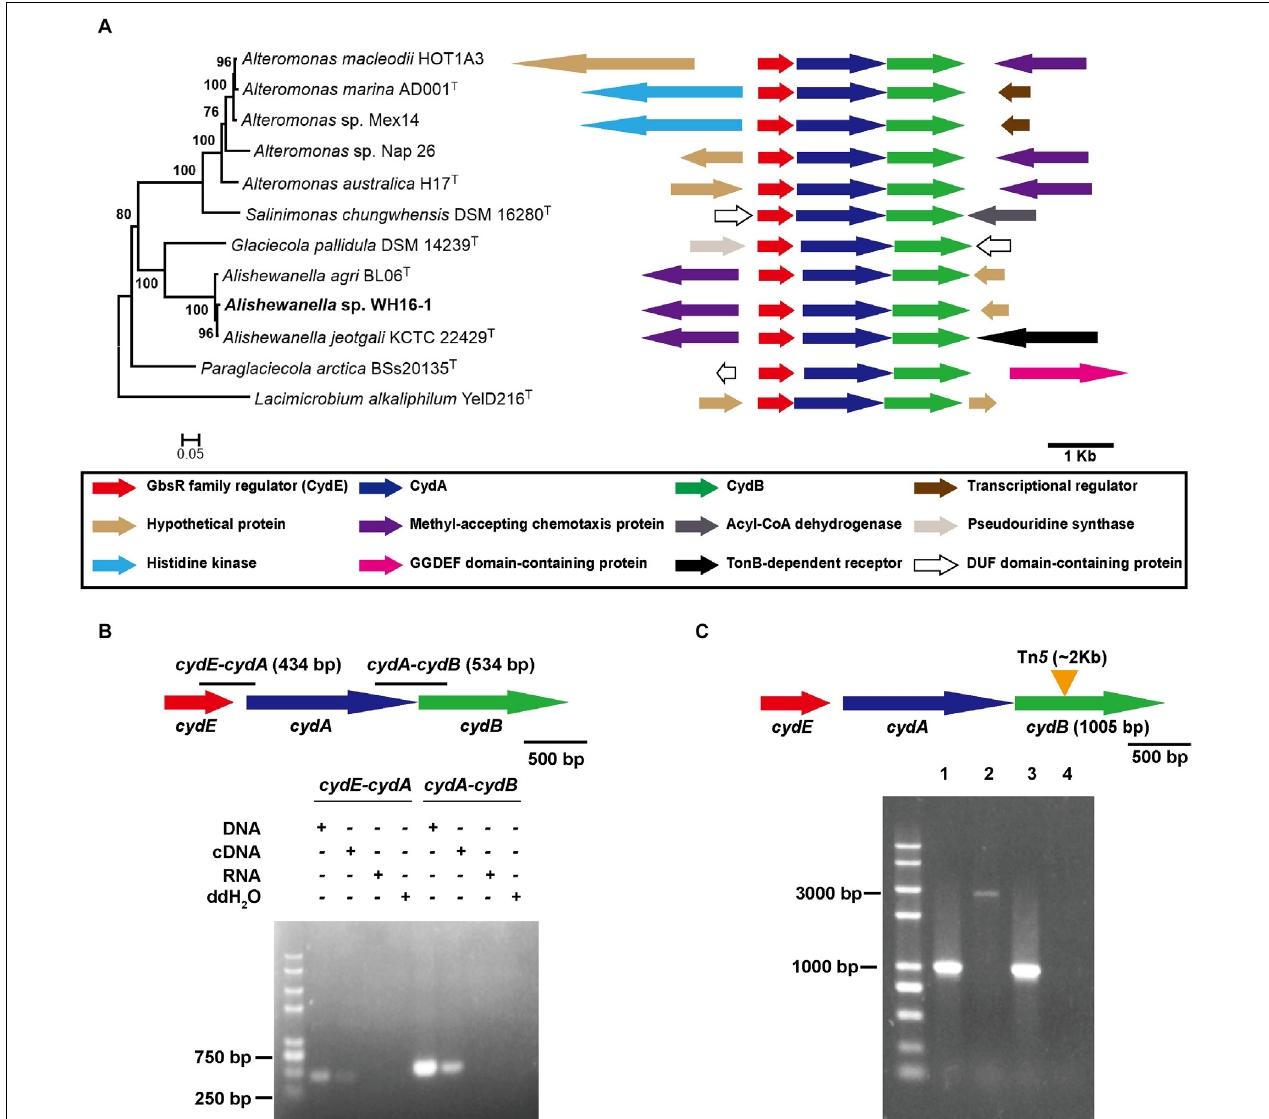
FIGURE 1 | Analysis of cytbd gene operon, cydB mutation, and complementation. (A) The amino acid-based phylogenetic relationship of the cytbd gene cluster and its adjacent gene arrangement in Alteromonadaceae family members. (B) cydE , cydA , and cydB were co-transcribed. (C) Physical evidence of cydB mutation and complementation. Lanes 1–3 are the PCR-amplified products of wild-type, (cid:77) cytbd , and (cid:77) cytbd -C by primers cydB F/ cydB R, respectively. Lane 4 is a negative control. The Tn 5 insert fragment is also approximately 1.8 kb. Consequently, the PCR product of the mutant strain is approximately 1.8 kb longer than PCR products of the wild-type and complemented